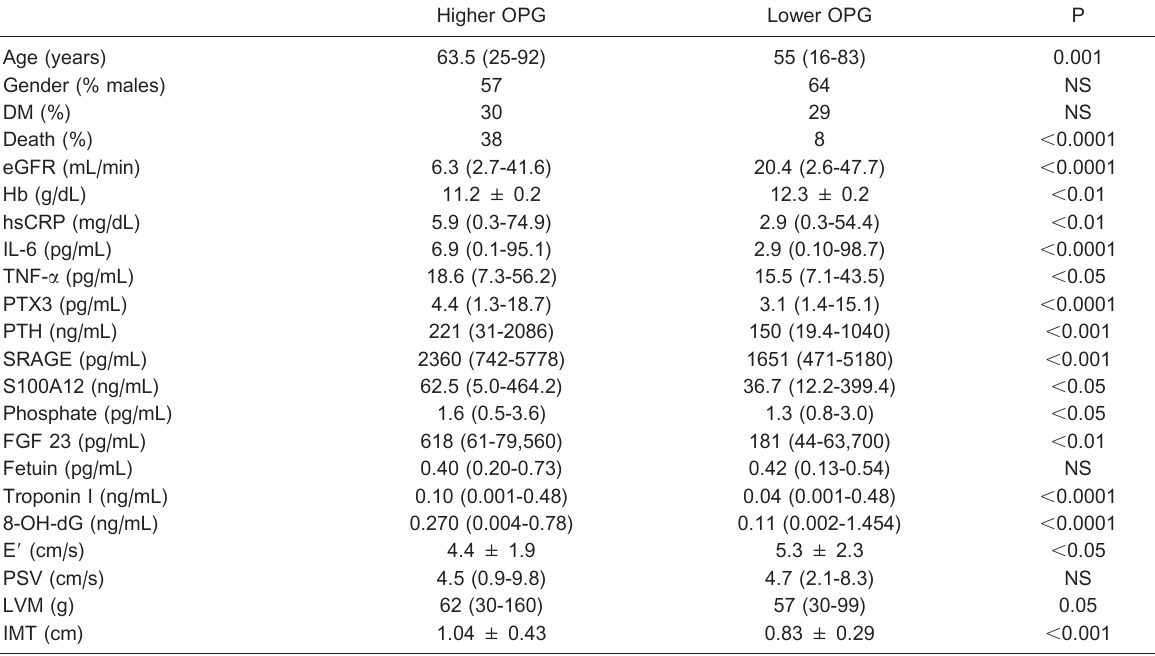
Table 2. Clinical, laboratory and echocardiographic findings, according to the median of osteoprotegerin (OPG) levels (8.1 pM).